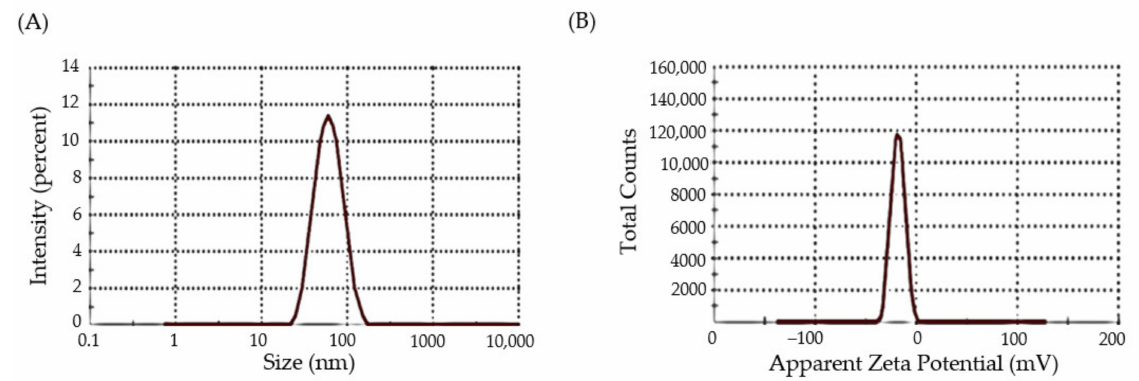
Figure 4. ( A ) DLS profile of DFX-AuNPs (80 nm) ( B ) Zeta-potential of DFX-AuNPs ( − 18